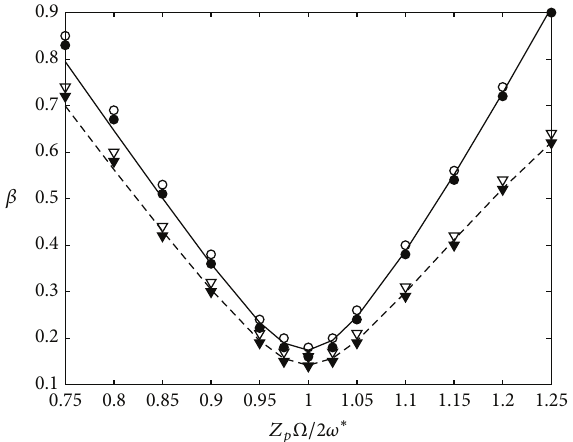
Figure 10: Dynamic instability regions with different numbers of blades 𝑍 𝑝 and 𝜁 = 0.05. “—,” “- -,” instability region boundary with 𝑍 e ” “ I ,” “ 󳶃 ” “ 󳶚 ,” stable and 𝑍 𝑝 = 5, 𝑝 = 3 by Floquet’s method, “ unstable data with 𝑍 𝑝 = 5, 𝑍 𝑝 = 3 by DSC